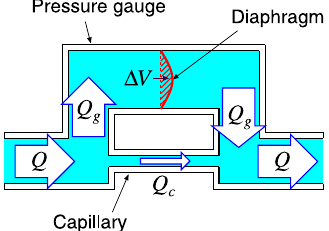
Fig. 10 Internal model of the pressure gauge. Δ V is the capacity increment of one of two compartments divided by a diaphragm in the pressure gauge. There is an apparent flow through the pressure gauge when Δ V